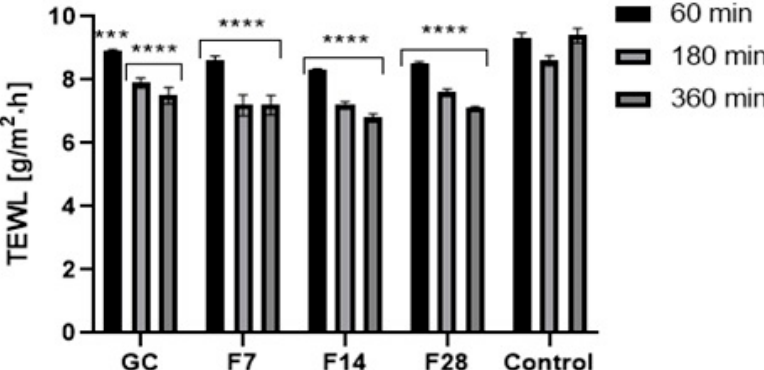
Figure 13. Influence of coffee beans’ and kombucha ferments’ extracts on transepidermal water loss (TEWL). Data are the mean ± SD of five independent measurements. *** p < 0.0003, **** p < 0.0001.